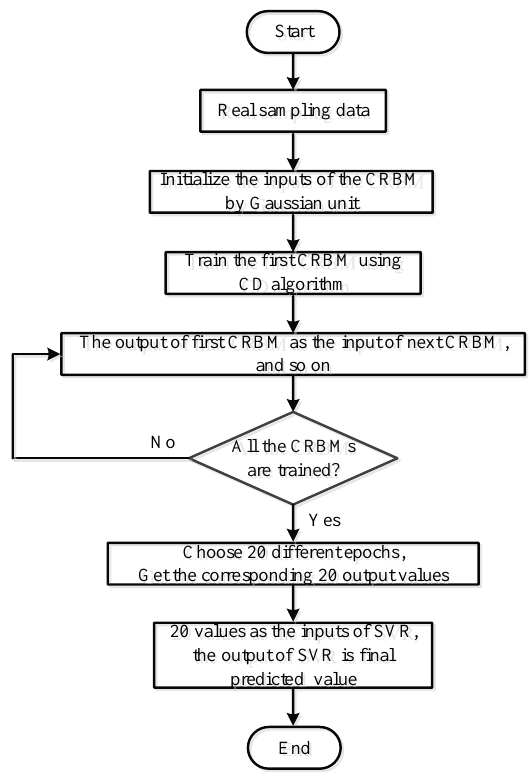
Figure 6. Flowchart of CRBM-DBN-ALO-SVR.